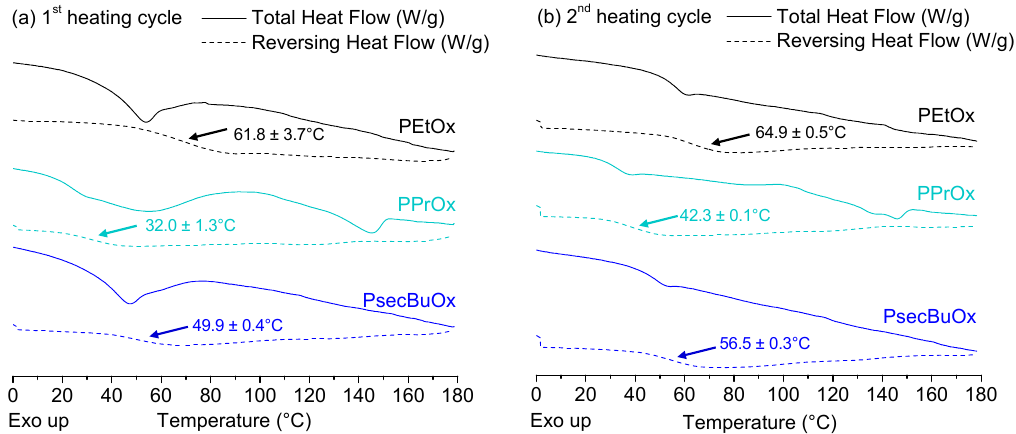
Figure 3. mDSC thermograms of the first ( a ) and second ( b ) heating cycle of PEtOx (black), PPrOx (cyan) and PsecBuOx (blue). Total heat flow (full line) and reversing heat flow (dashed line) are shown. Glass transitions are indicated with arrows in the reversing heat flow and the average glass transition temperature ( n = 3) is given for each PAOx. Created with Origin 8.5 from OriginLab (Northampton, MA, USA).